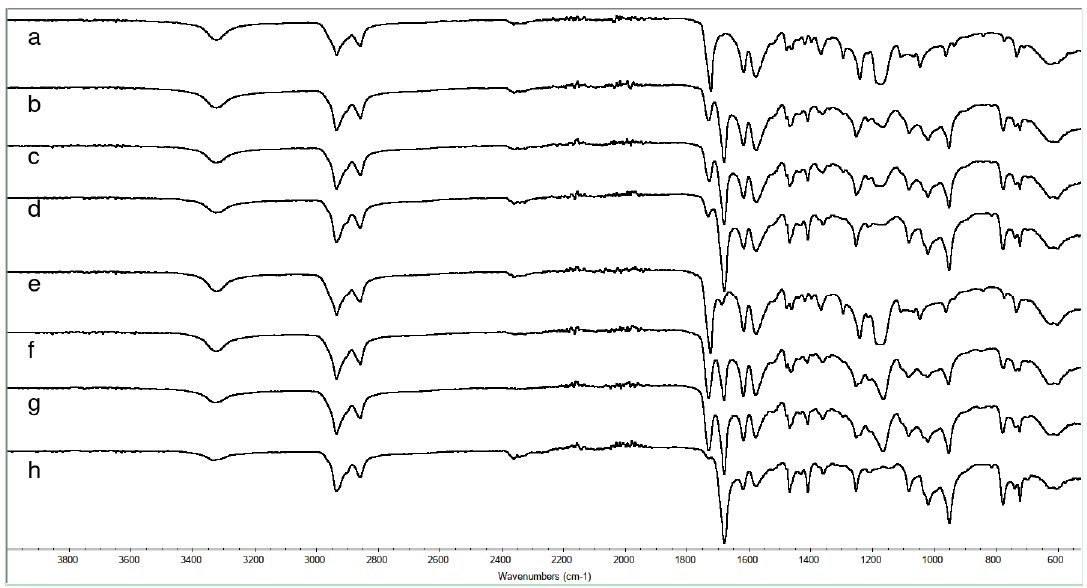
Figure 6. FTIR spectra of chitosan graft copolymers; ( a ) CG-PCL, ( b ) CG-B-2:1, ( c ) CG-B-1:1, ( d ) CG-B-1:2, ( e ) CG-P-2:1, ( f ) CG-P-1:1, and ( g ) CG-P-1:2, ( h ) CG-PTCL.